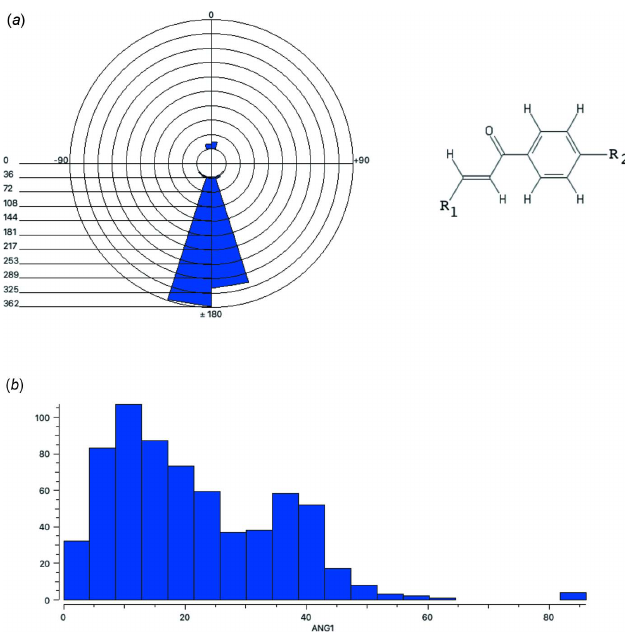
Figure 8 ( a ) Polar histogram of torsion angle R 1 —C C—C. ( b ) Histogram of the dihedral angle between the planes of the double bond and the phenyl ring.